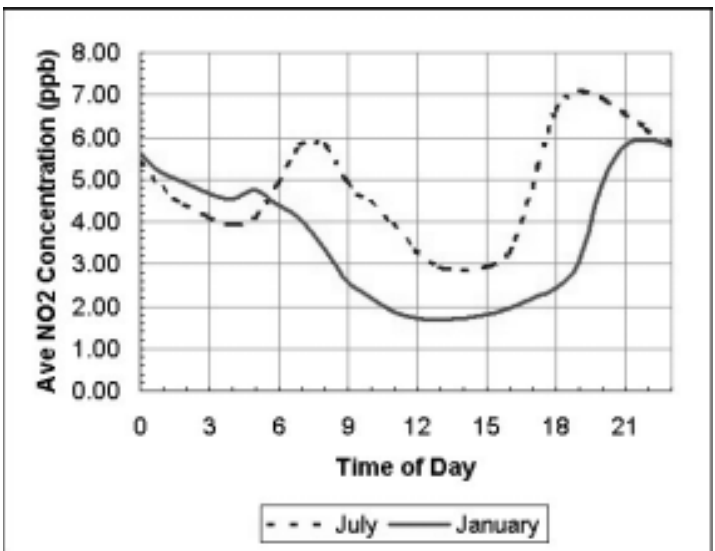
Figure 5. Seasonal comparison of hourly average NO2 concentration